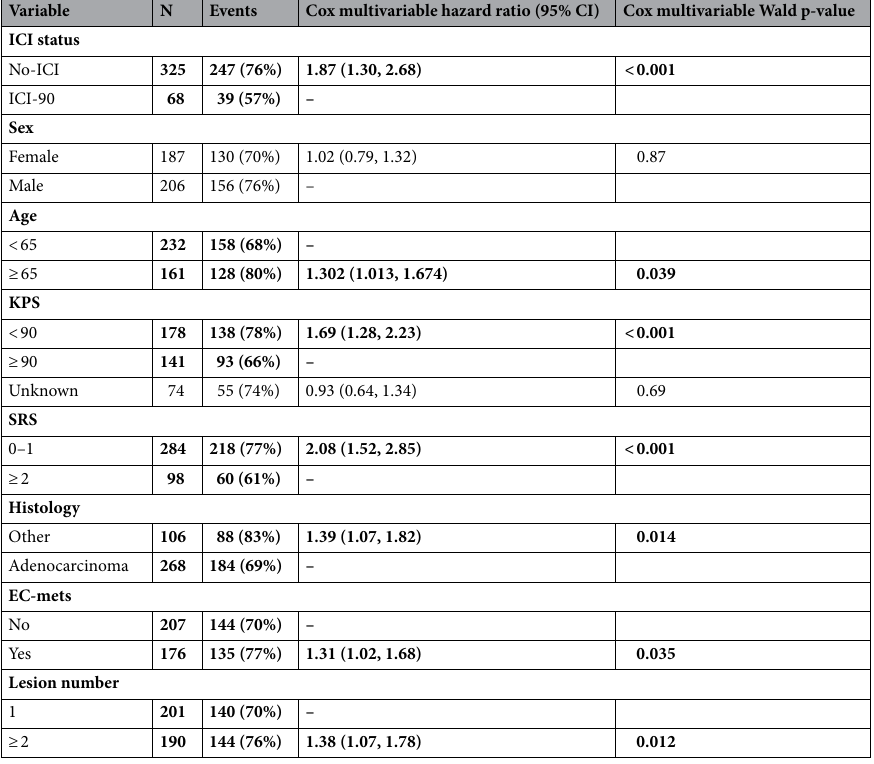
Table 3. Multivariate analysis on the effect of ICI within 90 days. Significant differences (p < 0.05) are bolded.